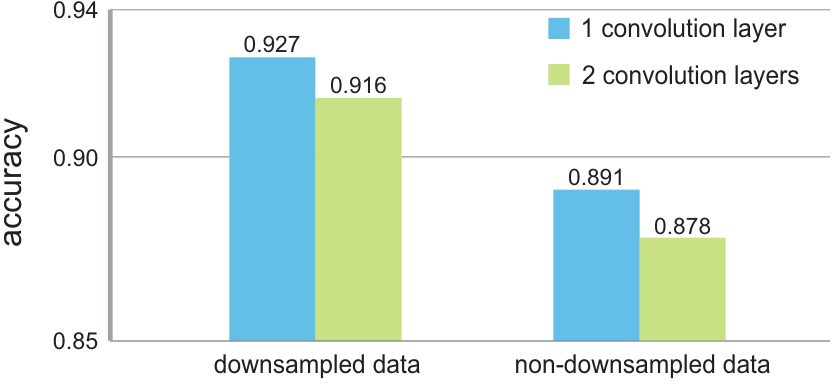
Figure 5. Difference in mean accuracy for the model with the highest performance using down-sampled and non-down-sampled